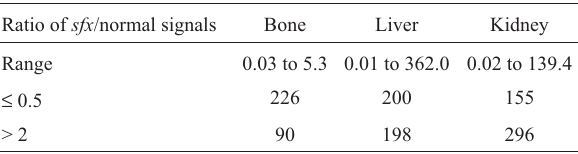
Table2 - Genesdifferbymorethana2-foldvaluebetween sfx andnormal control.